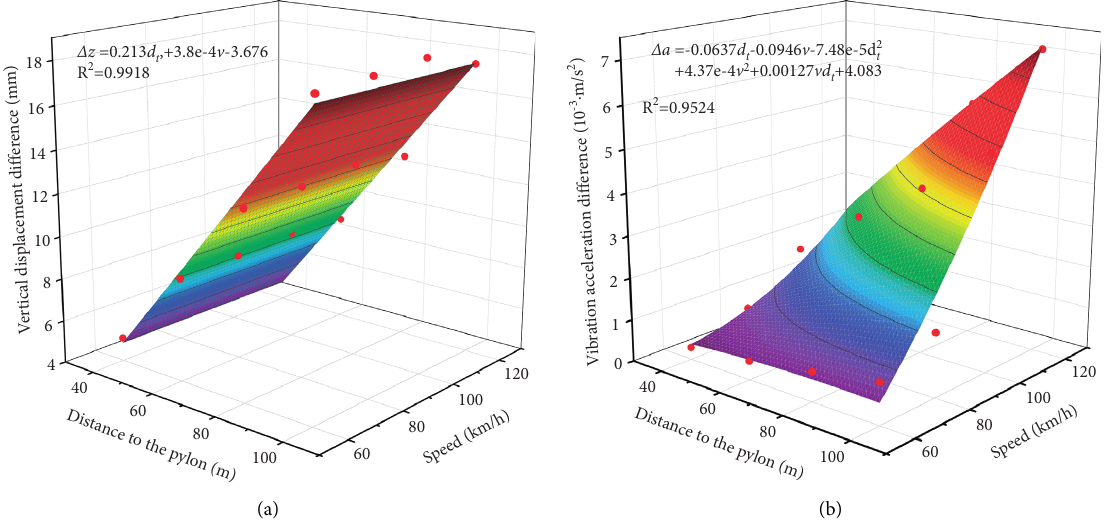
Figure 22: The nonlinear fitting of the dynamic response difference. (a) The vertical displacement difference. (b) The vertical vibration acceleration